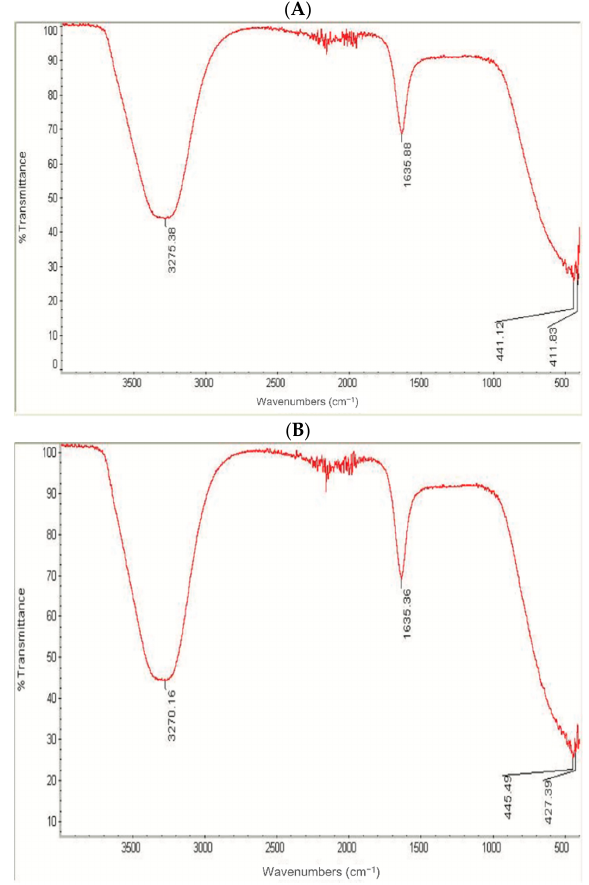
Figure 5. FT-IR images of AgNPs obtained using O. forsskalii seeds ( A ) and for those prepared by A. arabica gum ( B ). 3.1. Antimicrobial Capability of Phyto-Fabricated AgNPs